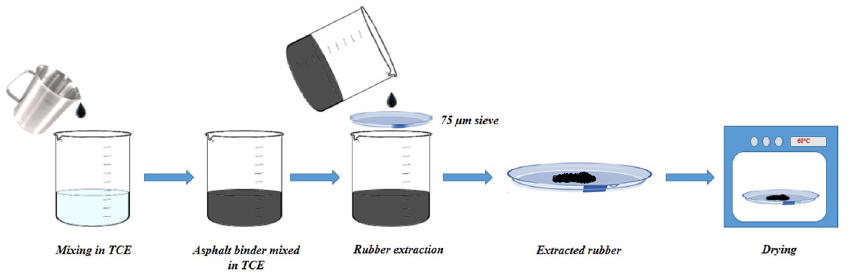
Fig 4. Schematics for rubber extraction